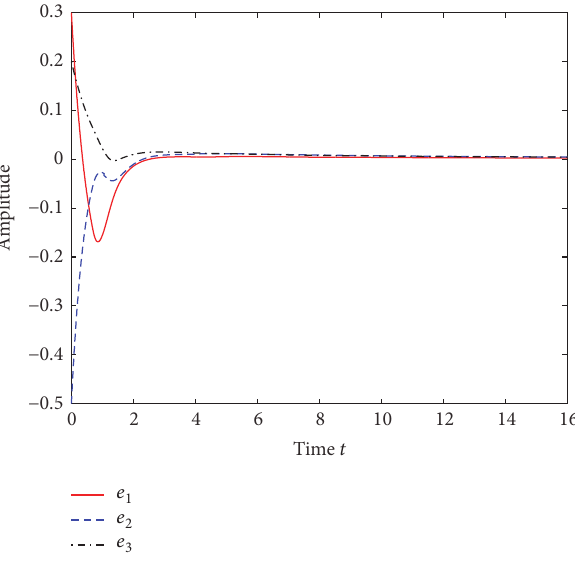
Figure 2: The response of the error 𝑒 ( 𝑡